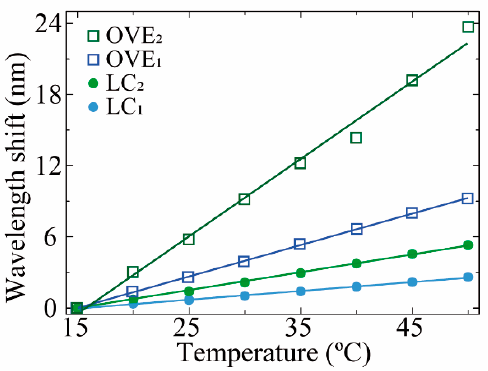
Figure 8. The wavelength shift of LC 1 (closed blue circle), LC 2 (closed green circle), OVE 1 (opened blue square), and OVE 2 (opened green square) with temperature. The colored solid lines represent the linear fits applied to each respective dataset.